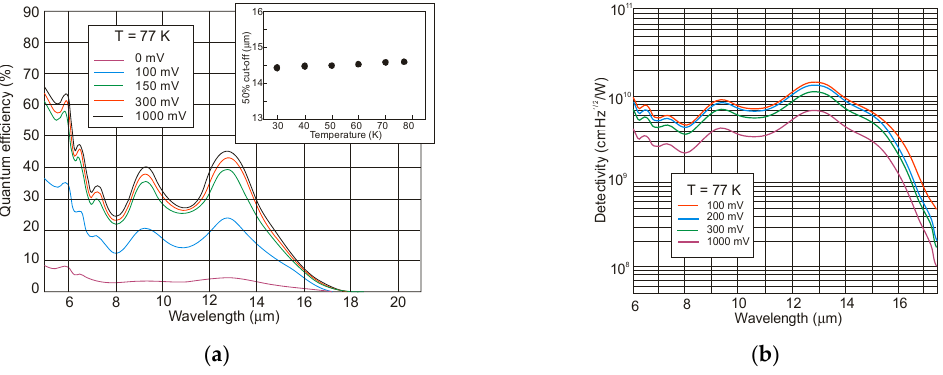
Figure 60. Spectral characteristics of LWIR T2SLs InAs/InAsSb photodiode: ( a ) QE spectrum with different applied bias at 77 K. Inset: 50% λ cut-off versus temperature; ( b ) the calculated shot noise and Johnson noise limited D* at 77K for different applied bias (after [164]).